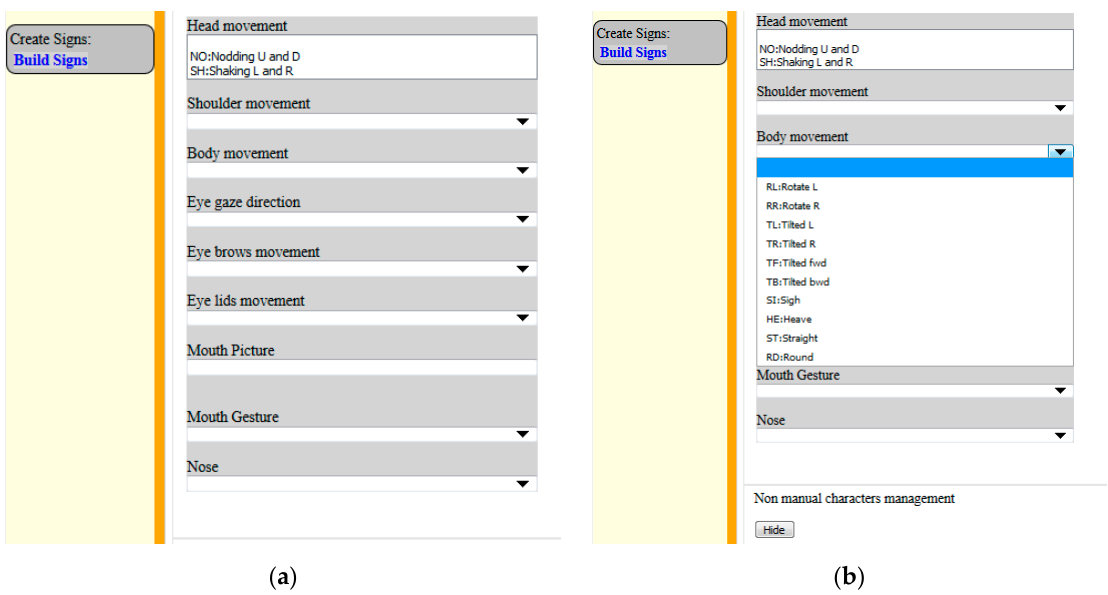
Figure 6. Implementation of non-manual entities annotation; ( a ) Non-manual feature list; ( b ) Available values for non-manual feature Body Movement.